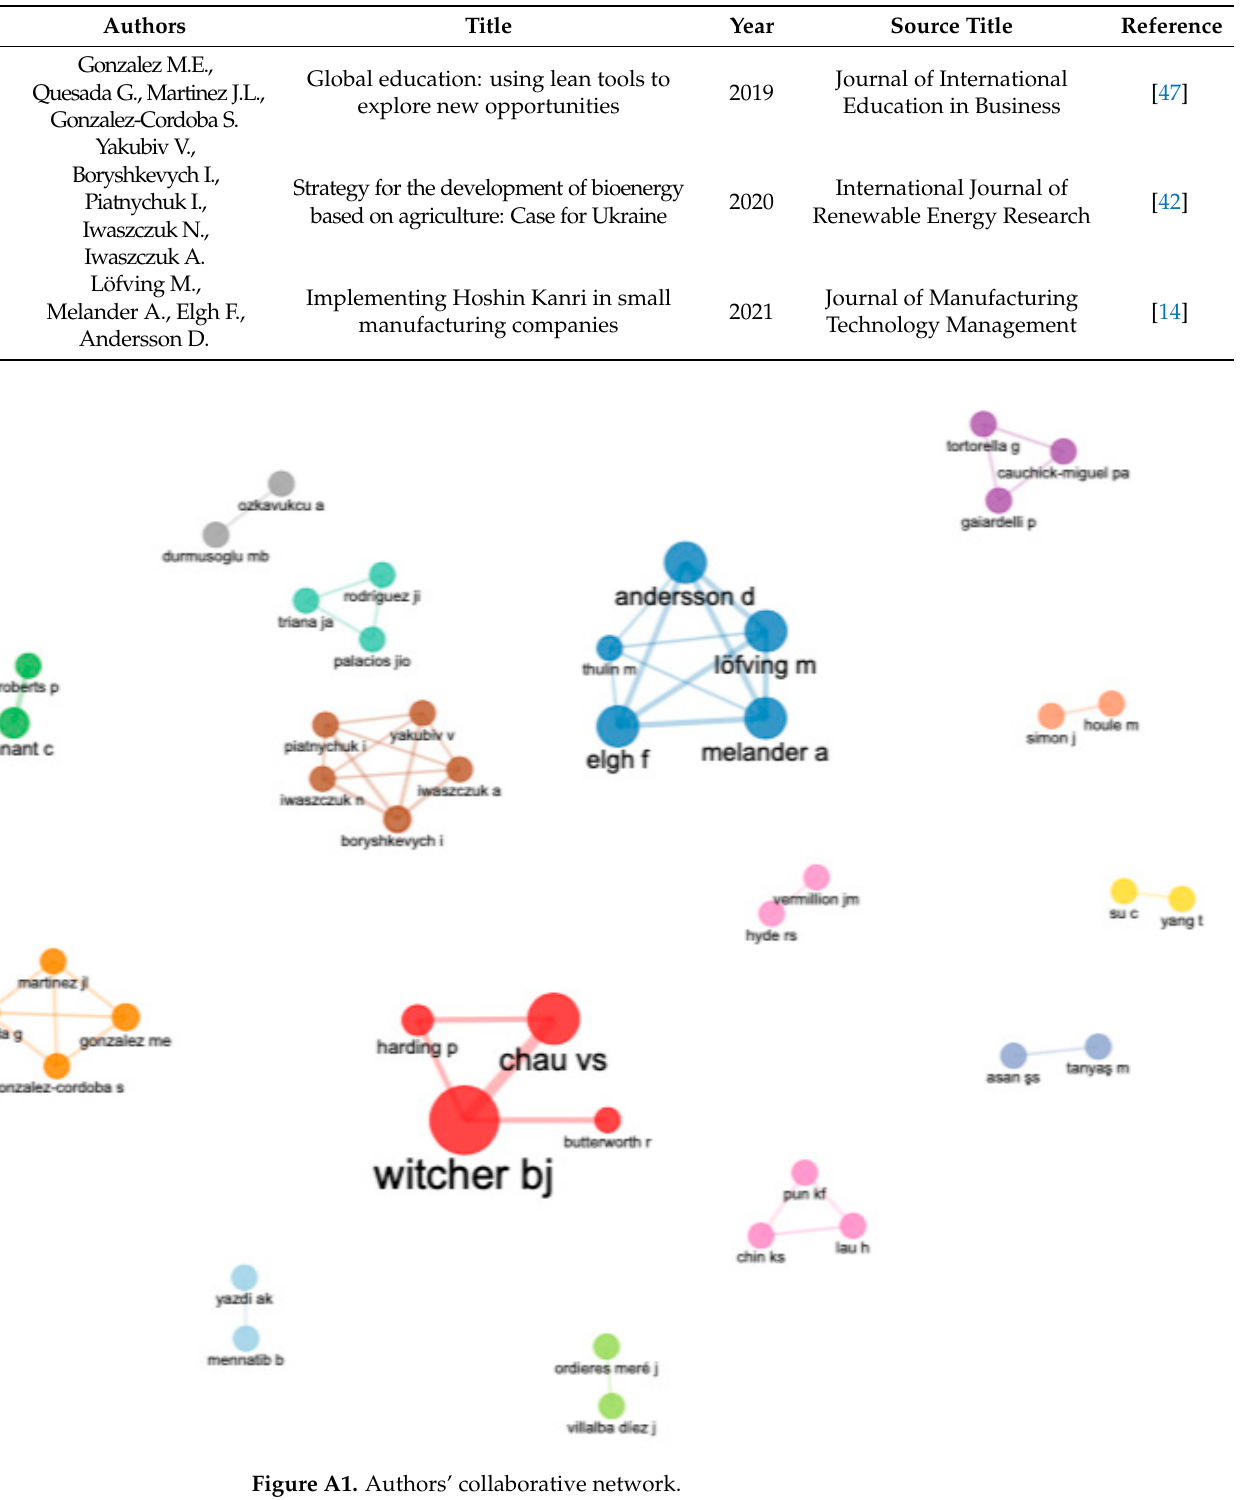
Figure A2. Authors’ co-citation networks.